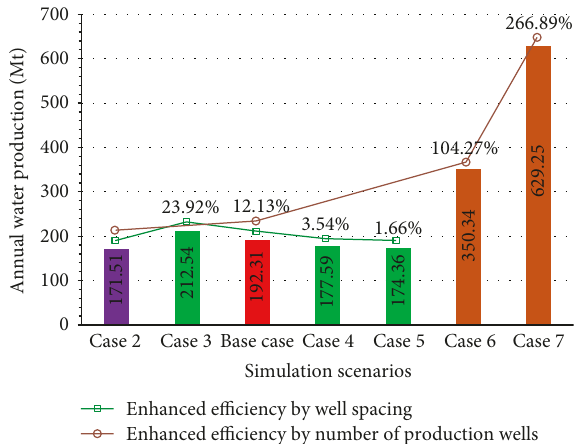
Figure 13: The pressure evolution curve at the monitoring point under di ff erent well distance layout